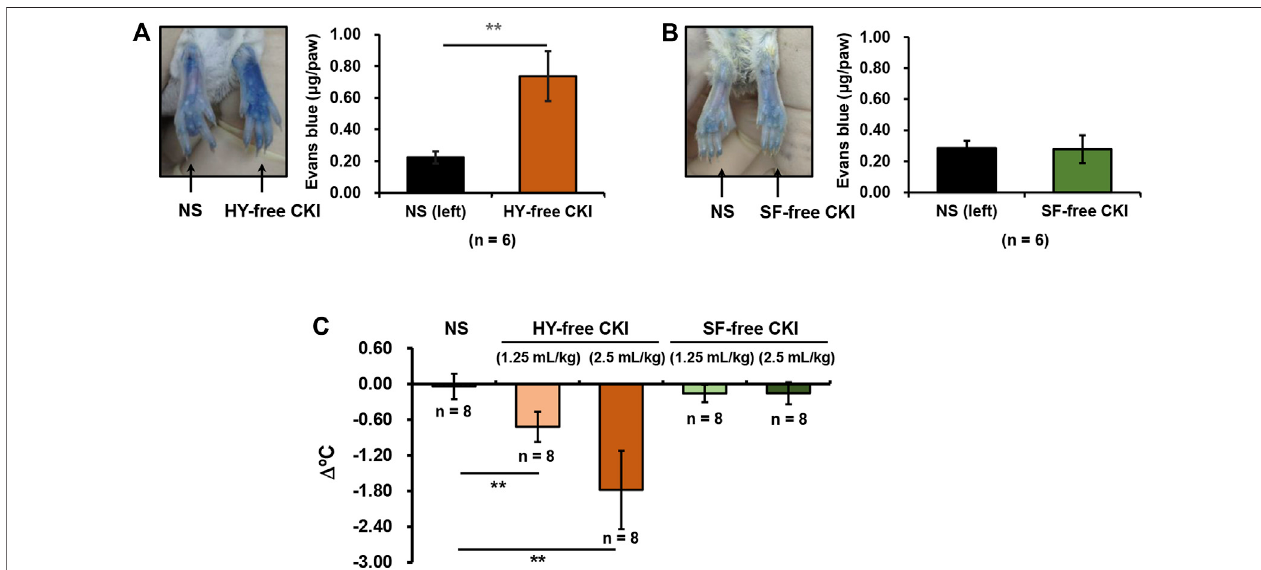
FIGURE 6 | HY-free CKI but not SF-free CKI contributes to NIN-IHRs. (A-B) HY-free CKI was able to cause Evans blue leakage in the mouse paw. Mice were injected (i.v.) with Evans blue (0.65 μ mol).Five minutes later, right paw of mice wasintraplantarly injected with (A) HY-free CKI or (B) SF-free CKI (10 μ l/paw), and the left paw was injected with equivoluminal NS. Thirty minutes later, the mice were euthanized and photographed. Paw tissues were collected and Evans blue in the paw tissueswasextracted byDMF at50 ° Covernight ( > 20 h).OD valueswereread at 620 nm.Theconcentrationofthe dyein thepaw tissue wascalculated according to the standard curve of Evans blue. ** p < 0.01. (C) HY-free CKI was able to cause hypothermia in propranolol-pretreated mice. The mice were pretreated (i.v.) with propranolol (0.118 μ mol/mouse).Twenty minutes later, the mice were intraperitoneally injected with HY-free CKI or SF-free CKI (1.25 ml/kg -2.5 ml/kg). The mice in the negative control group were received equivoluminal NS. Thirty minutes later, the rectal temperature was measured. ** p < 0.01. CKI, Compound Kushen Injection; HY, Heterosmilax yunnanensis Gagnep.; NIN-IHRs, non-immunologic immediate hypersensitivity reactions; NS, normal saline; OD, optical density; SF, Sophora fl avescens